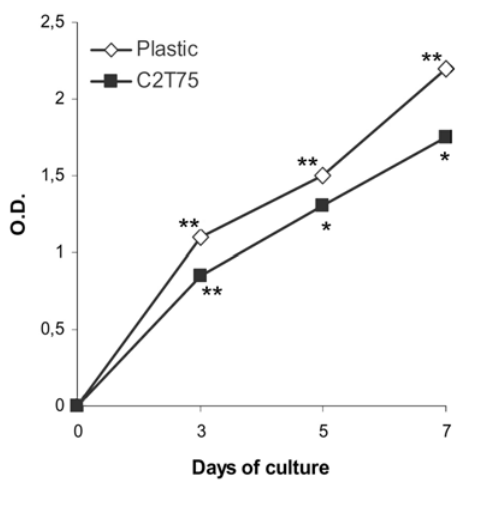
Figure 6. Proliferation of J111 cells grown up to seven days on plastic ( (cid:134) ) and on the collagen membrane C2T25 ( (cid:132) ) evaluated by the MTT method. Data are expressed as mean values of four replicates. * p<0.05; ** p<0.01 compared to the previous time